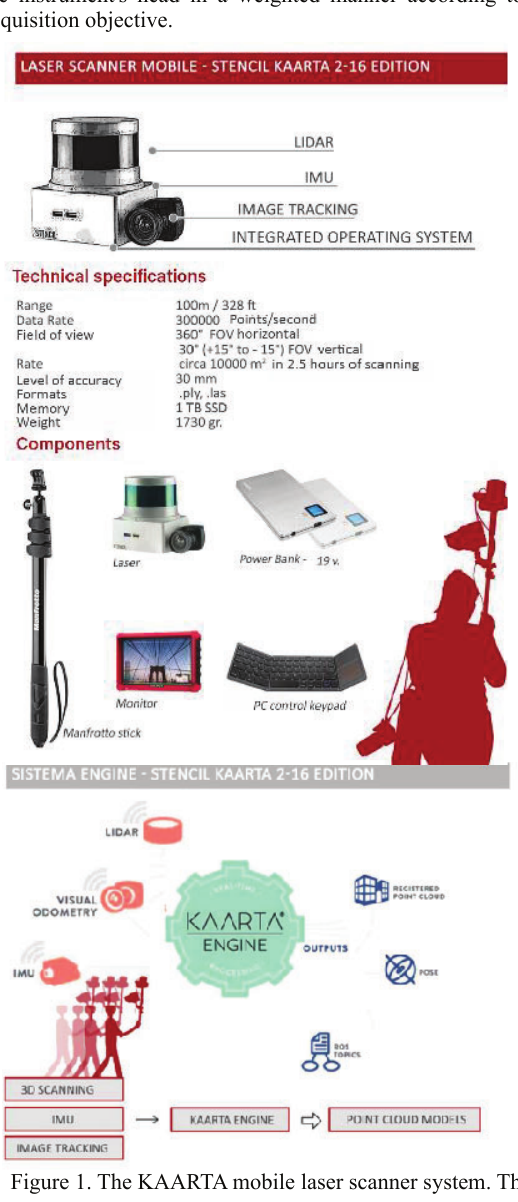
Figure 1. The KAARTA mobile laser scanner system. The instruments is based on proprietary SLAM technology that Figure 2. Some framing photos of the case study chosen for the works through the superimposition of data, i.e. on simultaneous experimentation, in particular it is via mino, historic center of localization and mapping and at the same time allow you to Florence, estimate the position of the instrument and generate a digital model of the detected scene.